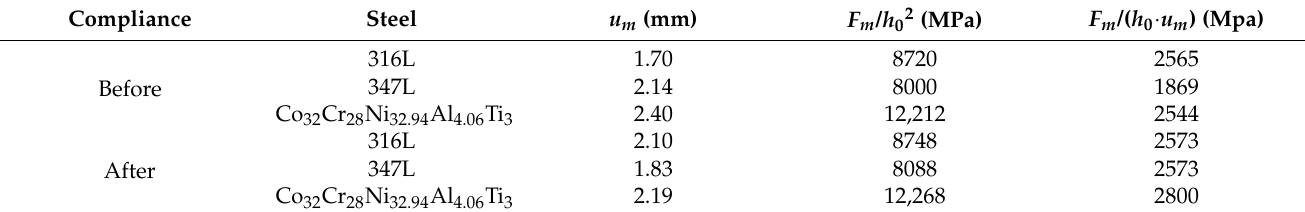
Table 5. Characteristic parameters (maximum force) of the SPT curve before and after compliance